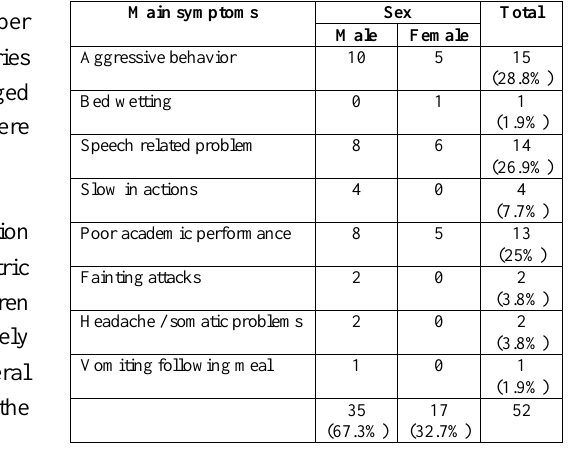
Mental and behavioural symptoms vs.